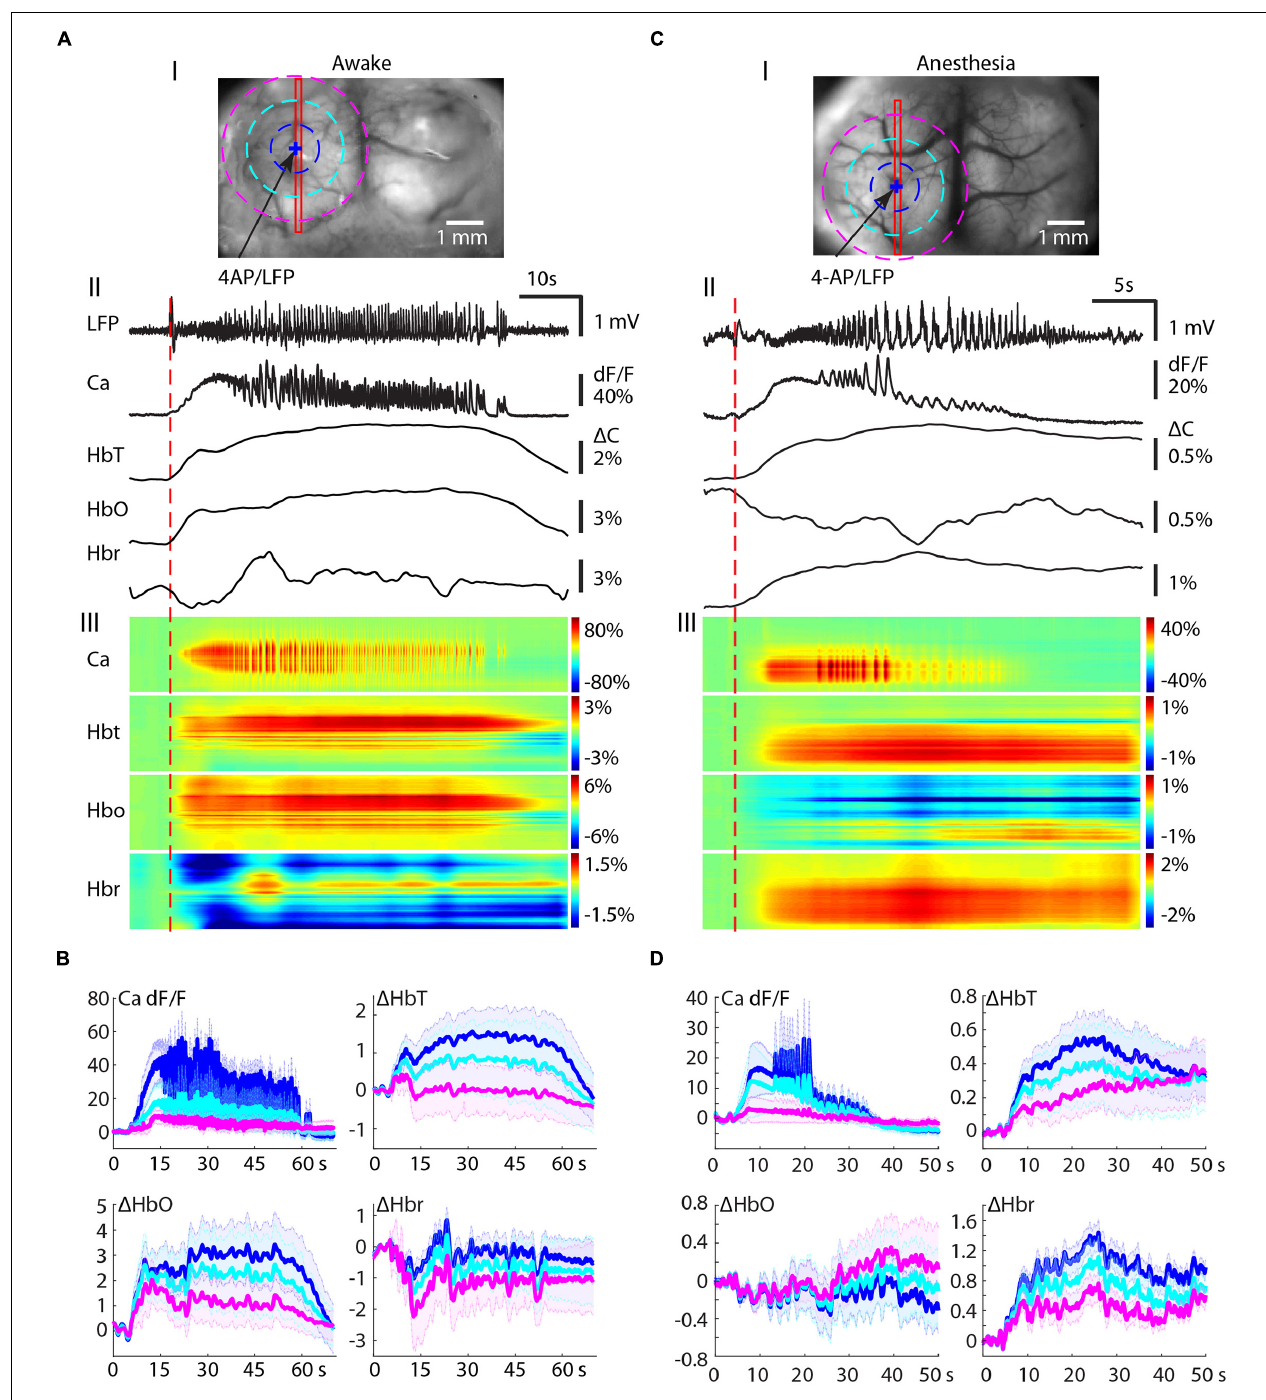
FIGURE 2 | Ipsilateral propagation of calcium and hemodynamic signals in awake and isoflurane-anesthetized mice. (A) Ipsilateral propagation of ictal event in an awake mouse. (A-I) The field of view. The blue arrow indicates the 4-AP/LFP electrode. A blue + indicates a pixel PiOI from within the 4-AP injection site from which the signals are shown in panel (A-II) . A red rectangle box shows a linear region of interest (LiROI) from which the calcium and hemodynamic signal are shown in panel (A-III) . Three dotted circles indicate three ring-RiOIs from which the averaged calcium signals are shown in panel (B) , each corresponding to the different color of the ring. The diameters of each RiROI are 0.7, 1.4, and 2.1 mm, respectively. (A-II) The LFP, calcium, and hemodynamic traces from the PiROI in the 4-AP injection site. (A-III) The calcium and hemodynamic dynamics from the LiROI. (B) The average calcium and hemodynamic traces from three RiOIs. (C) Ipsilateral propagation of ictal events in anesthetized mice. The arrangement of panel (C) is the same as in panel (A) . (D) The average calcium and hemodynamic traces from the three RiOIs.